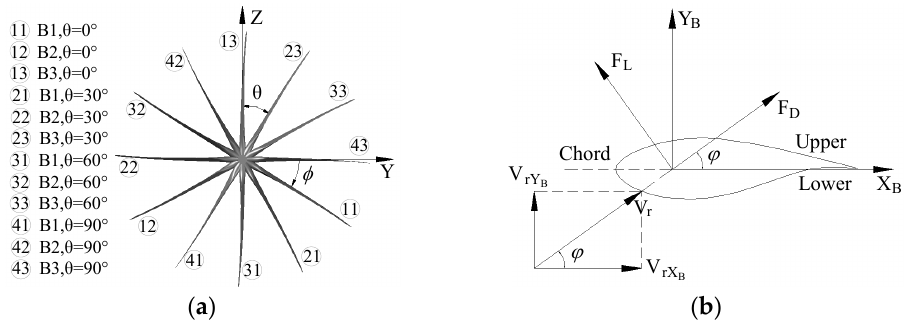
Figure 3. The schematic diagram of attack angles of blades: ( a ) Illustration of the blade positions; ( b ) Wind speed triangle for the airfoil section.